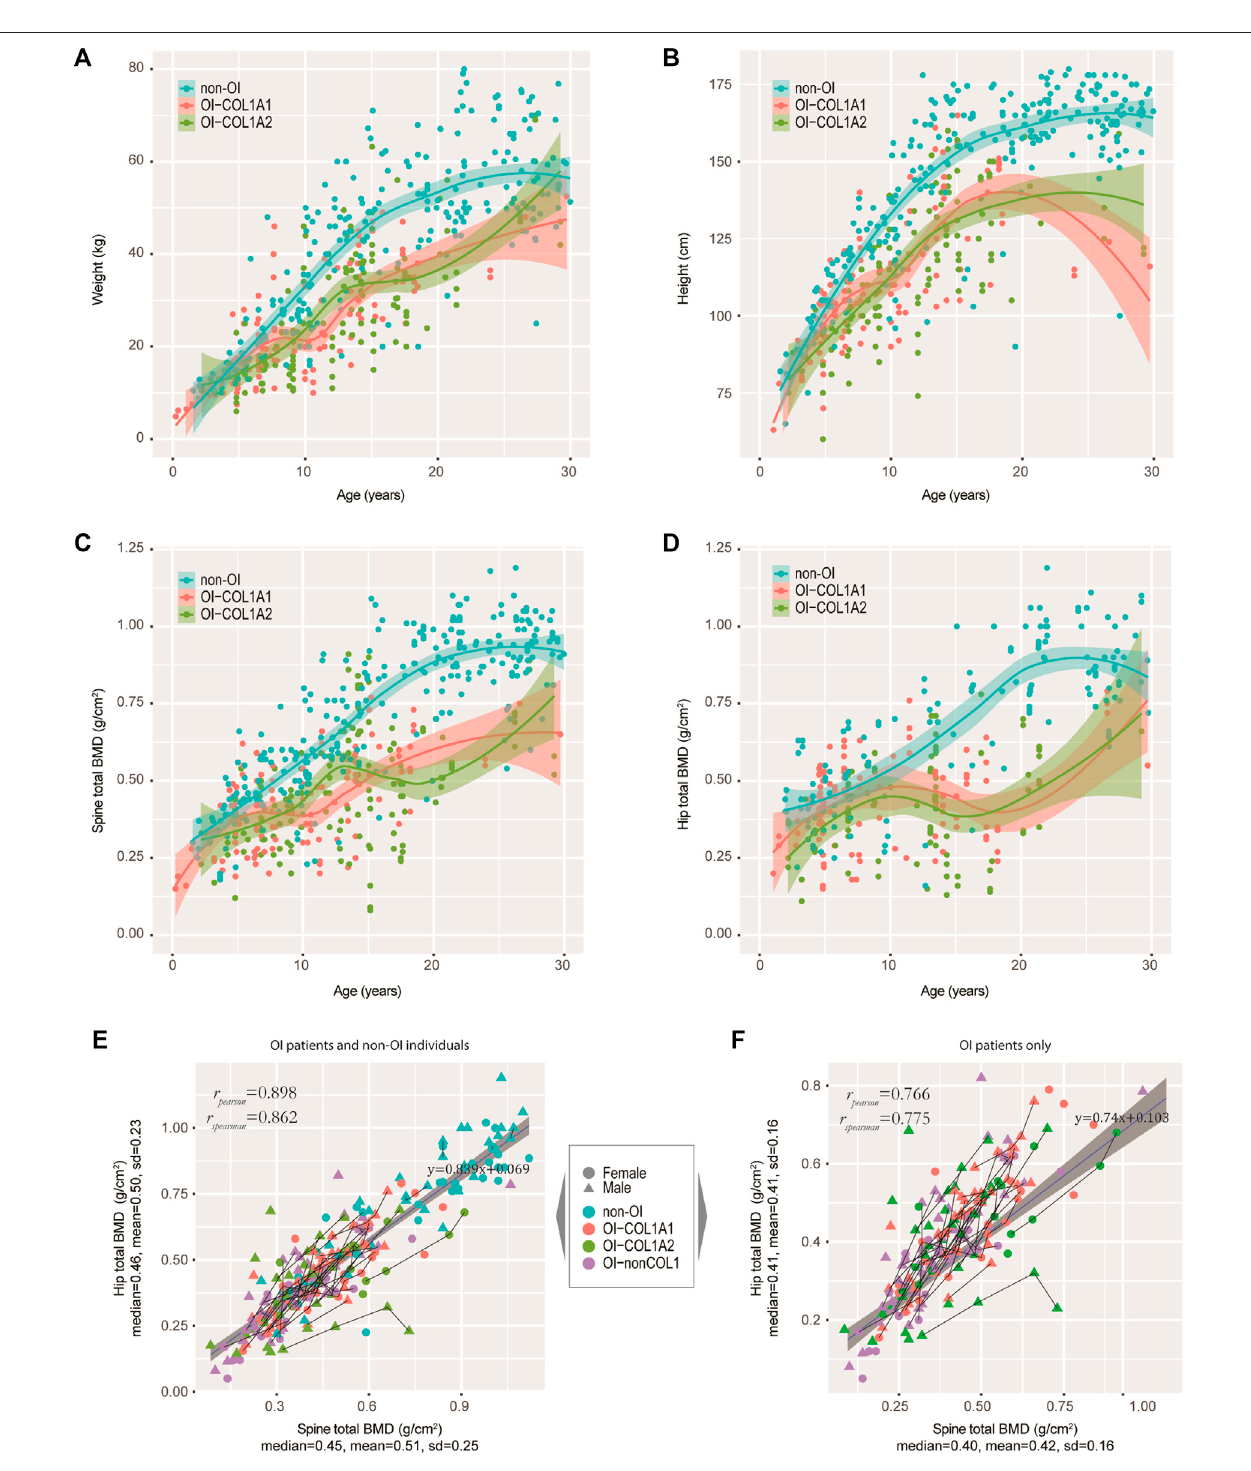
FIGURE 3 | Tracking the weight, height and BMD in our OI cohort. (A − D) Growth curves of weight (A) , height (B) , spine BMD (C) , and hip BMD (D) were tracked. Non-OIswererandomlyretrievedfromourhospitalinformationsystemwithgenderandagedmatched(peragegroup),andservedascontrolsforcomparison.Eachdot representsonemeasurementforoneindividual. (E) ScatterplotshowingthecorrelationbetweenspineandhipBMDsinourOIandnon-OIcohortscombined. (F) Scatter plot showing the correlation between spine and hip BMDs in our OI cohort only. Line segments indicated measurements of the same individuals.